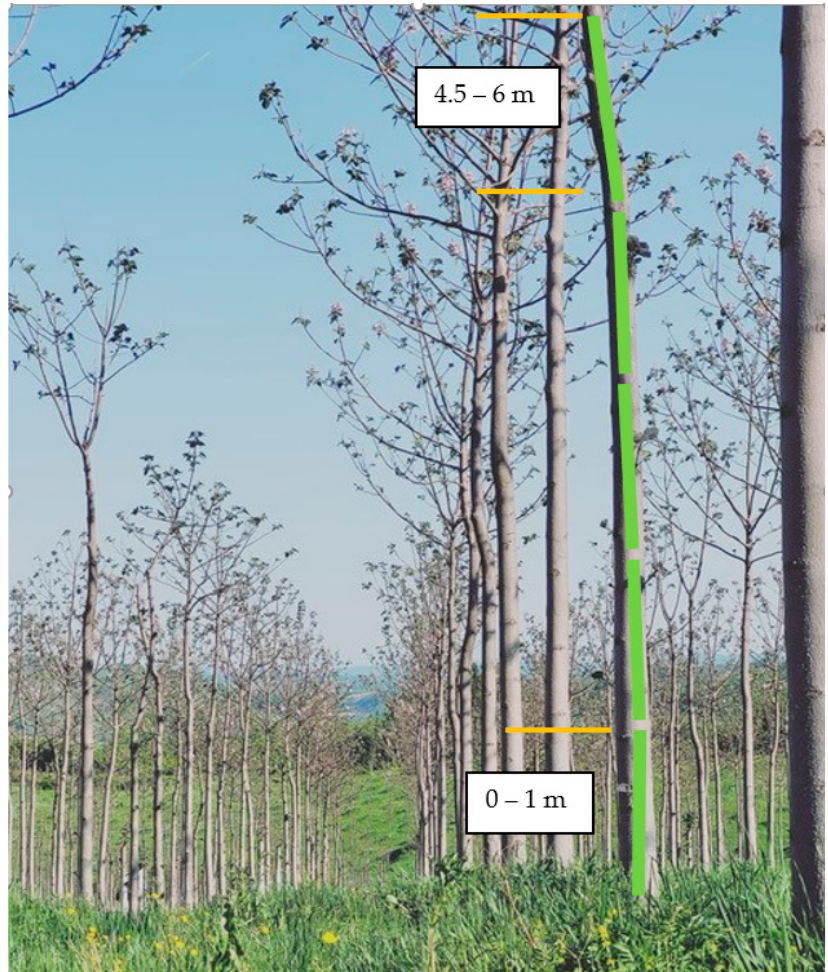
Figure 4. Two spots on the Paulownia stem (0–1 m and 4.5–6 m) selected after harvesting for the research investigation.